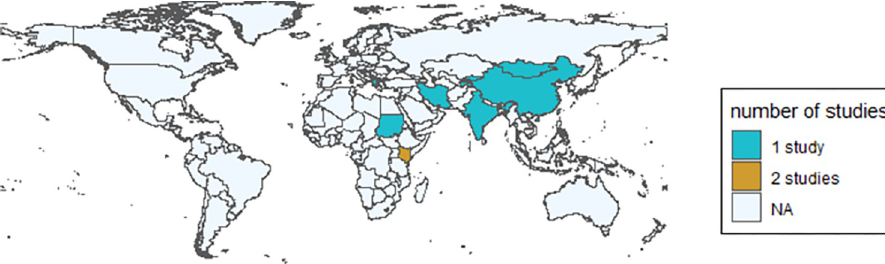
Fig 2. Countries with national or subnational Brucella burden studies estimates. Mapping and statistical testing were performed in R version 4.2.1. Maps were generated using the following packages: ggplot, rnaturalearth, rnaturalearthdata and